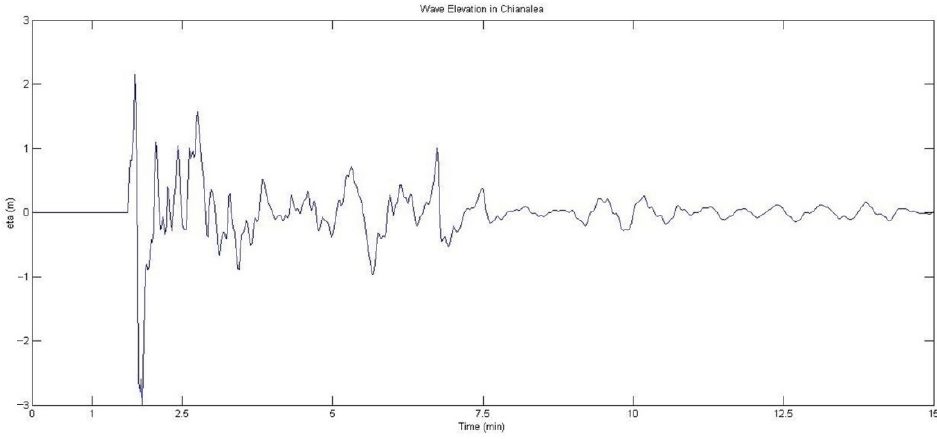
Figure 25. Free surface elevation obtained from the depth-integrated model in Scilla Chianalea.